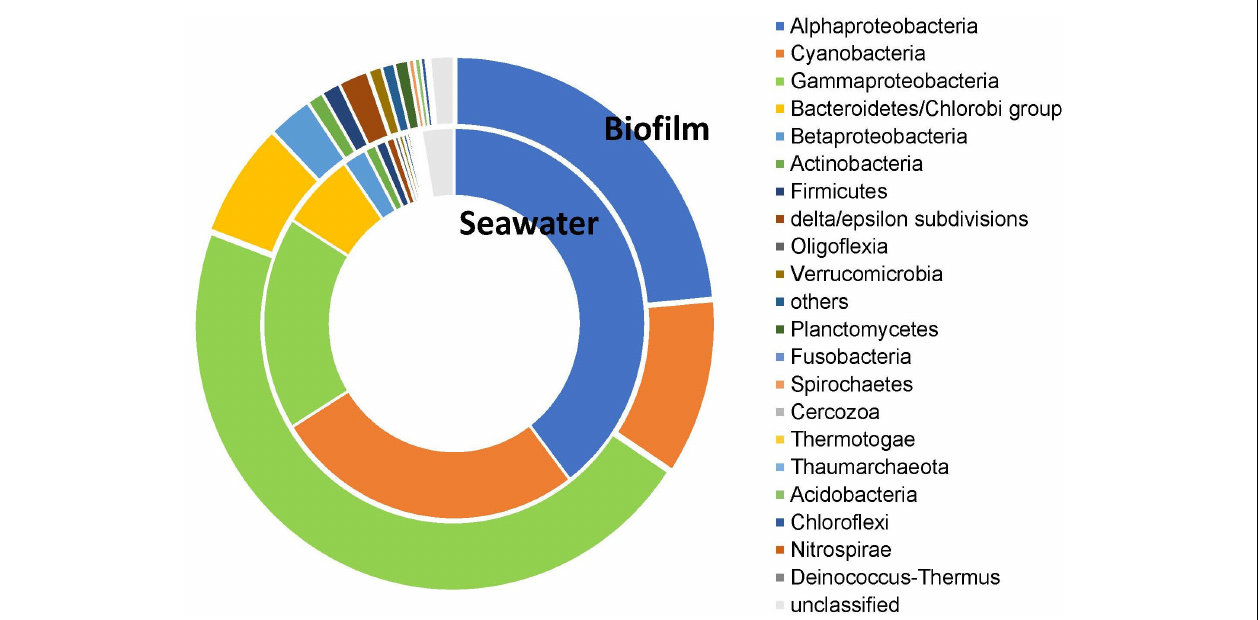
FIGURE 4 | Distribution of source microbes of signal transduction genes in 101 biofilms and 91 seawater samples. The taxonomic affiliation of signal transduction genes was determined in the phylum level (class of proteobacteria) of each sample, and the average of source phyla in the biofilms and seawater microbial communities was calculated, respectively to generate the taxonomic affiliation pattern. In the biofilm microbial communities, Gammaproteobacteria contributed most signal transduction genes, whereas the most contributed bacteria were